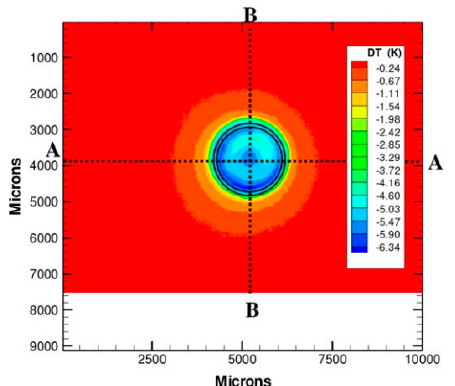
Figure 6. Temperature of the meniscus of methanol evaporating in a 1630 μ m diameter capillary tube. IR image obtained after subtraction of the same image taken with an empty tube by Buffone and Sefiane [ 60 ] . Reprinted by permission from Ref. [ 60 ] , Experimental Thermal and Fluid Science, Copyright © 2022 Elsevier.